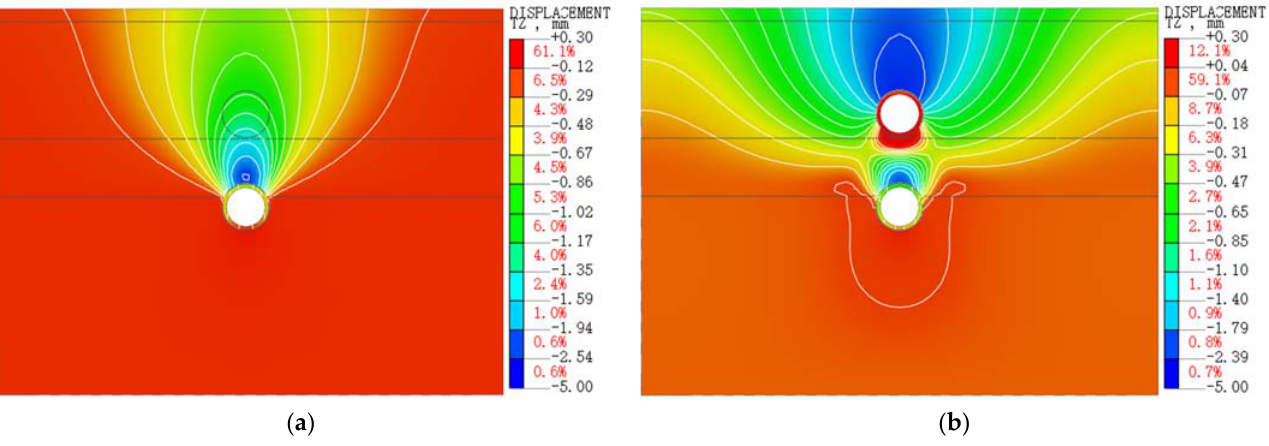
Figure 9. Vertical displacement cloud diagram of calculated model. ( a ) Completion of the lower pipe; ( b ) completion of the upper pipe.